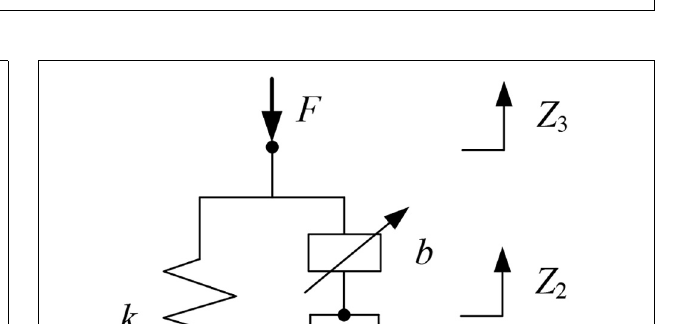
FIGURE 2 | Structural principle of the magnetorheological inerter.